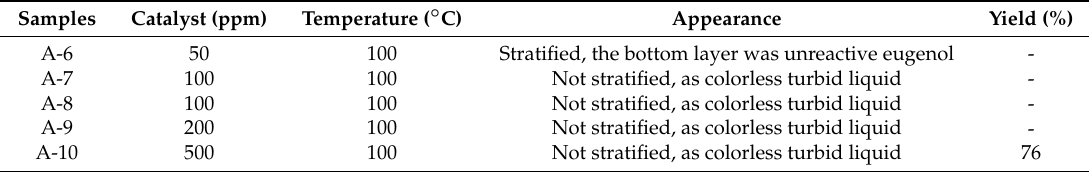
Table 2. Effect of catalyst concentration on activity of catalyst.